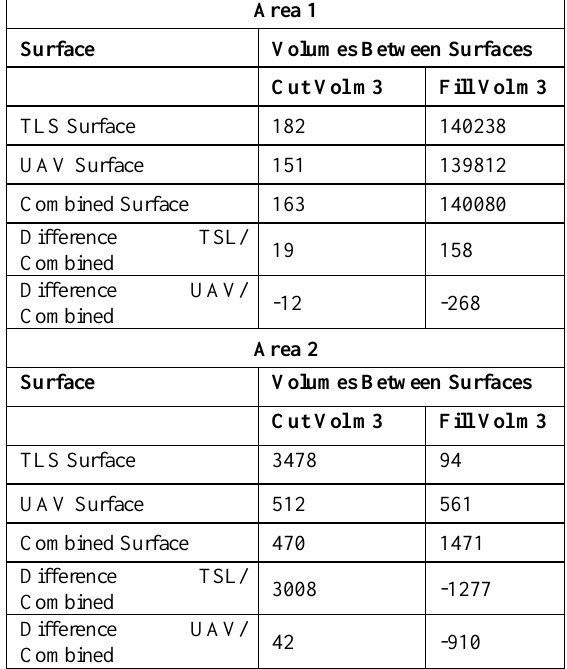
Table 1: Surface volume calculations between start stockpile surface and new surface